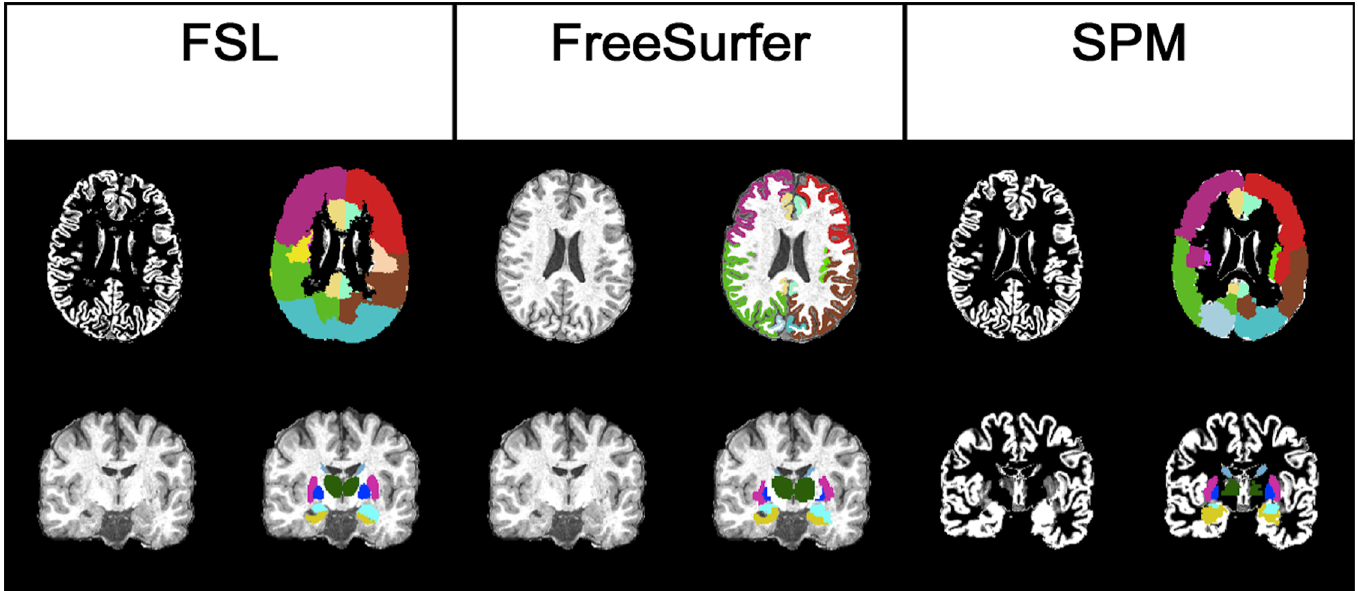
Fig 2. Segmentation obtained through different software packages with the lobes (upper row) and DGM (lower row) overlay, from left to right: FSL (FSL GM segmentation and GM segmentation+overlay), FreeSurfer (brain and brain+overlay) and SPM (SPM GM segmentation and GM segmentation+overlay).